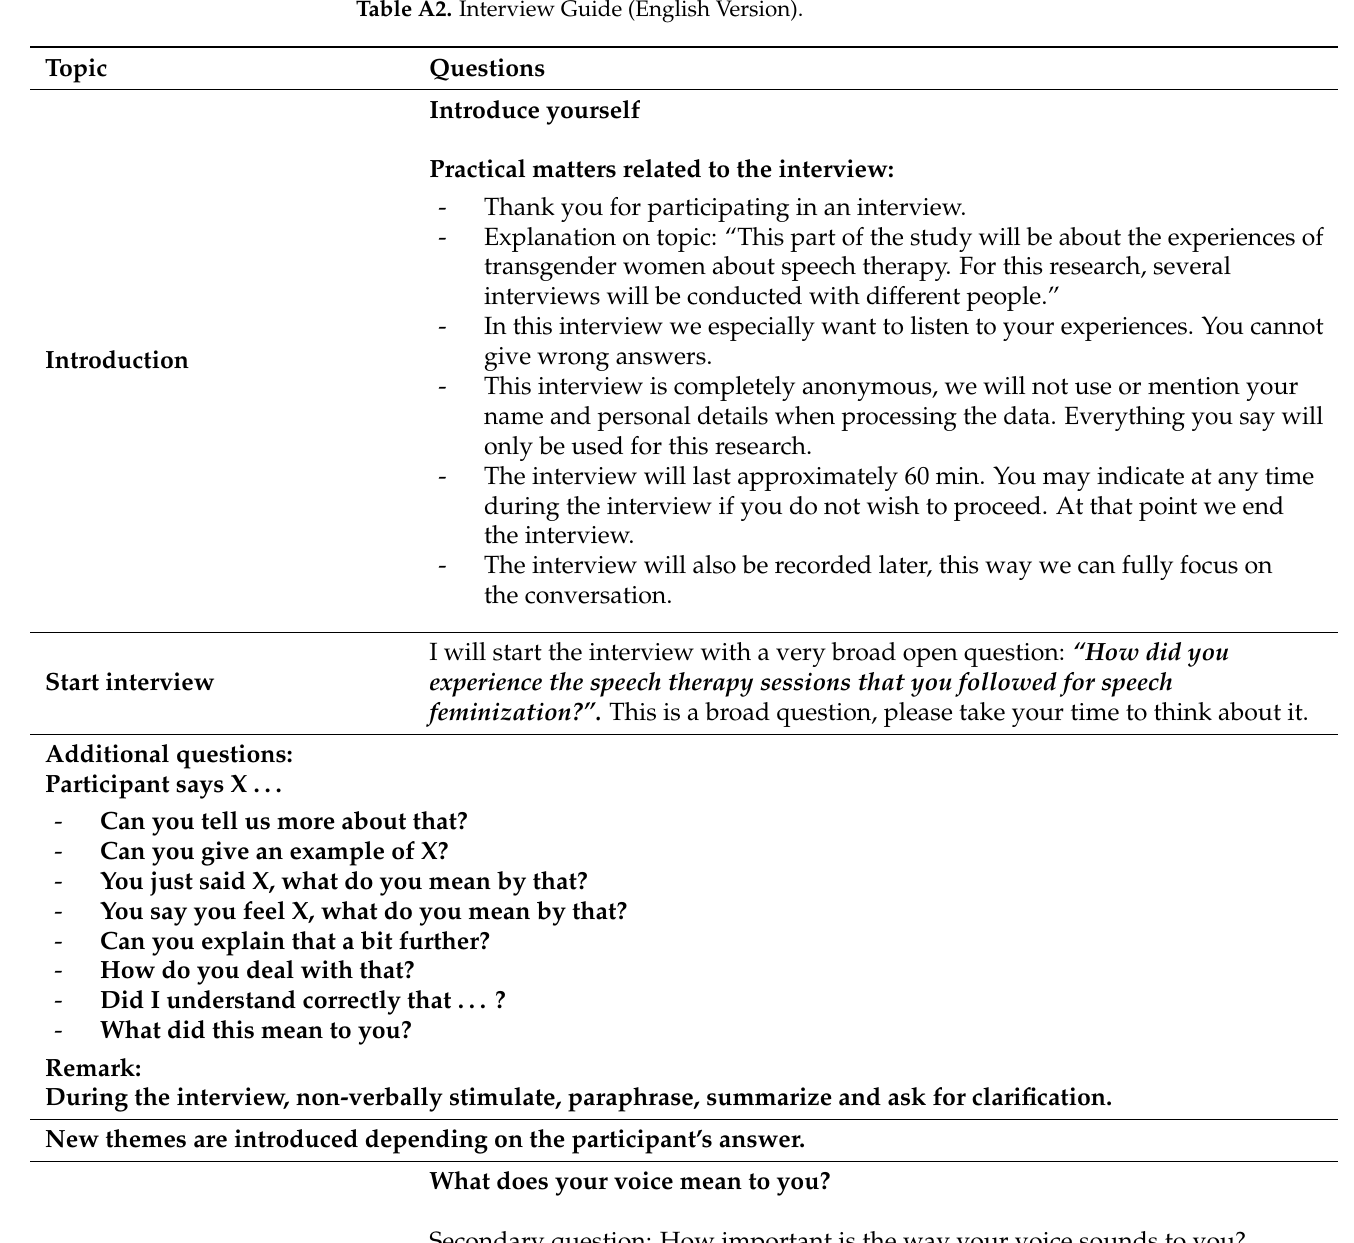
Table A2. Interview Guide (English